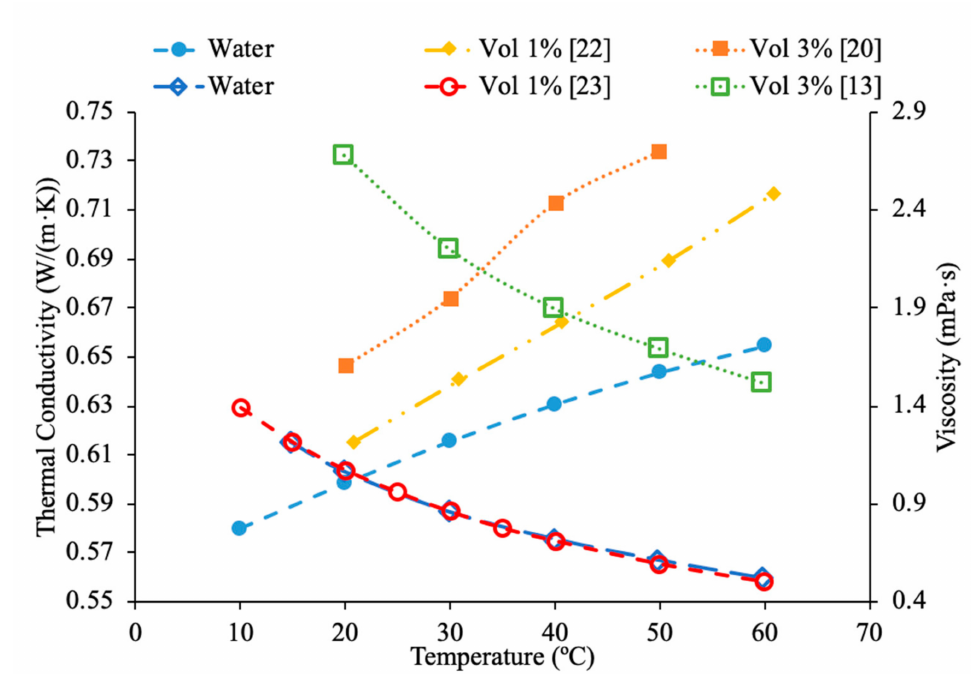
Figure 4. Thermal conductivity (increasing with temperature) and viscosity (decreasing with temper- ature) for Al 2 O 3 –water nanofluids at a volume fraction of 1% and 3%